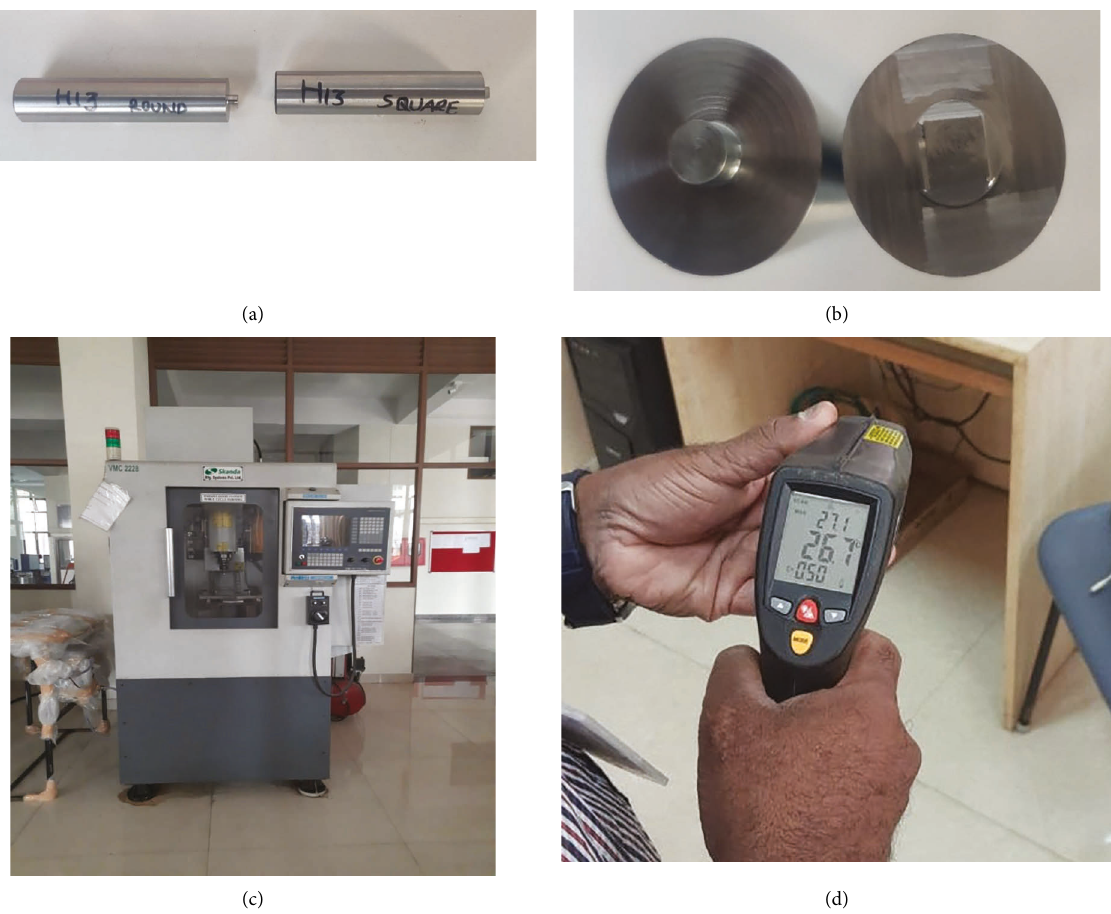
Figure 5: Hardened H13 steel tool with (a) round and square pin profiles. (b) Bottom section of the tools. (c) CNC milling machine. (d) Infrared thermometer.